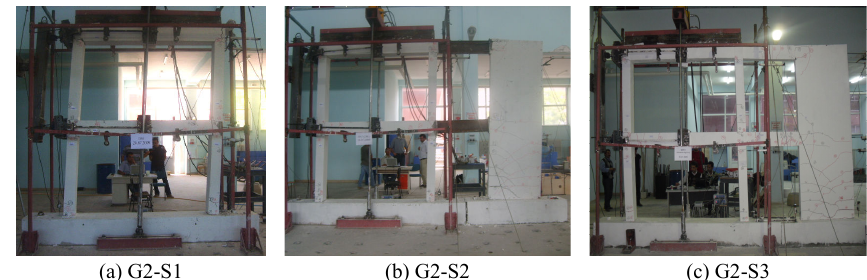
Figure 9. Post-test views of the 2 nd group test specimens (Ozturk, 2010) Fig. 9. Post-test views of the 2nd group test specimens (Ozturk,